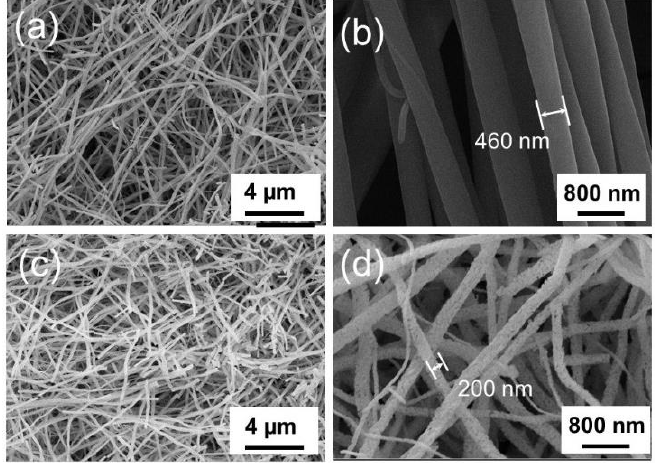
Figure 4. SEM images of ( a , b ) precursor of a NiO(10%) / NiTiO 3 composite nanofiber membrane, and ( c , d ) the same sample calcined at 800 ◦ C.